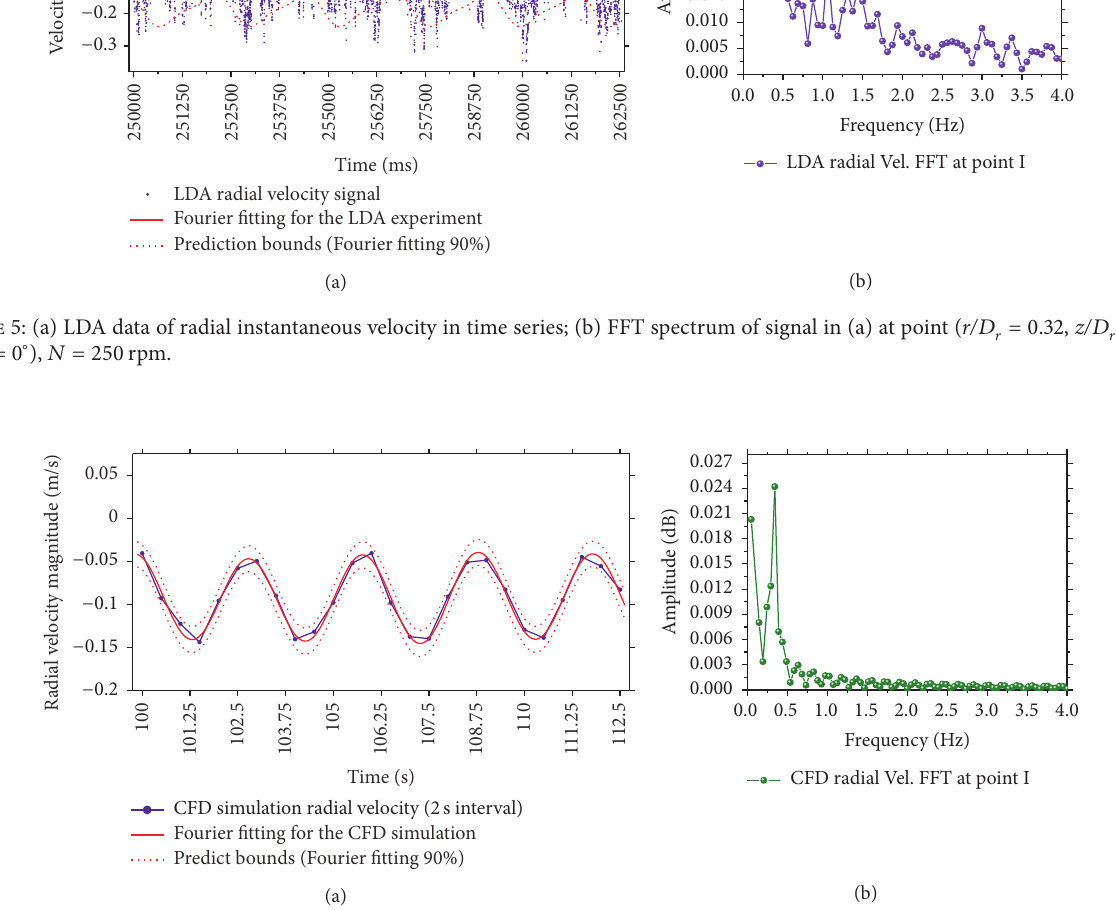
Figure 6: (a) Simulation of radial instantaneous velocity in time series; (b) FFT spectrum of signal in (a) at point ( r/ 𝐷 𝑟 = 0.32, z/ 𝐷 𝑟 = 0.38, and 𝜃 = 0 ∘ ), 𝑁 = 250